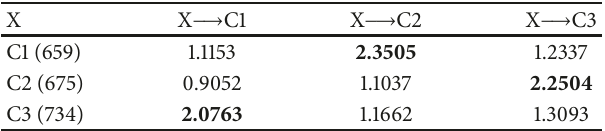
Table 5: The number of nodes in each cluster and the ratio of the numberofedgesbetweenclustersorinsidetheclustertothenumber of nodes in the cluster in Gnutella network with 100% of initial number of nodes in all clusters.